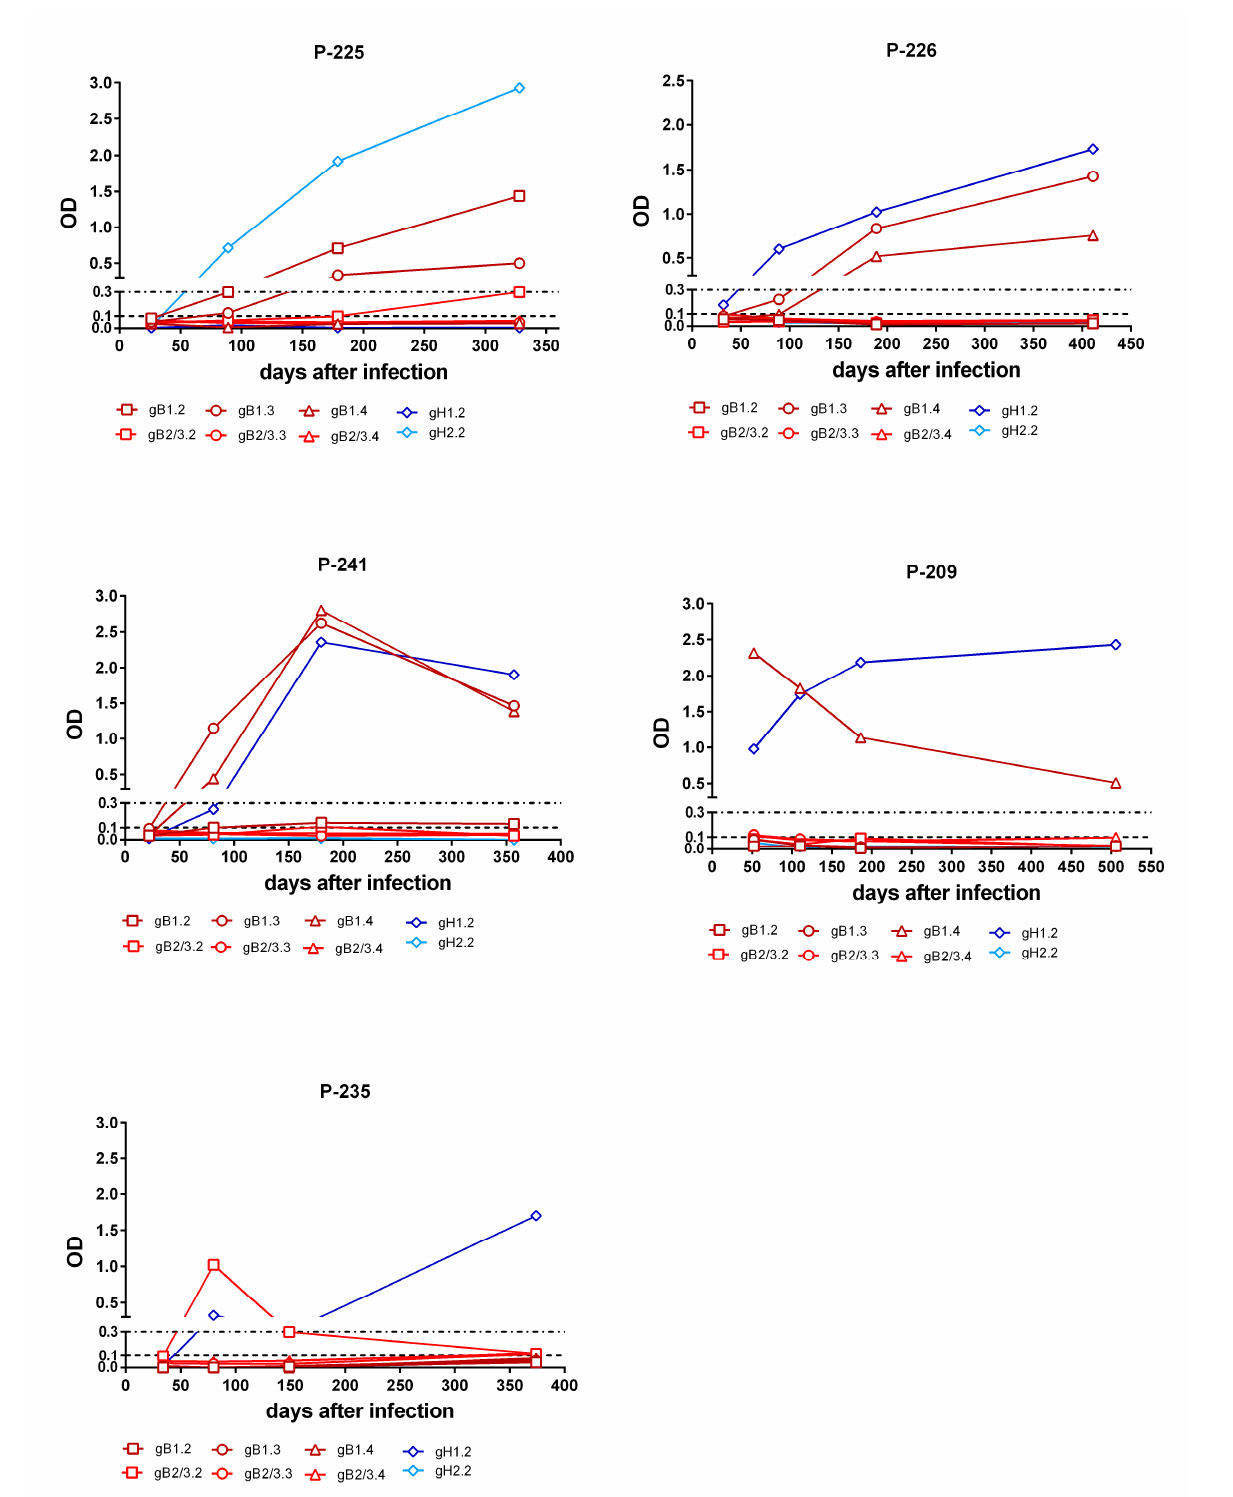
Figure 7. Kinetics of genotype-specific IgG antibody response to peptides representing gB and gH genotypes in single women with primary infection. In subjects P-225 and P-226, the gB and gH IgG responses increases during the first year after infection. In subject P-241, the gB and gH IgG responses decreased over time. In subject P-209, the gB IgG response decreased and the gH IgG response remained constant with time. Finally, in subject P-235, the gH IgG response increased at late times (after 6 m) and the initial gB IgG response disappeared.